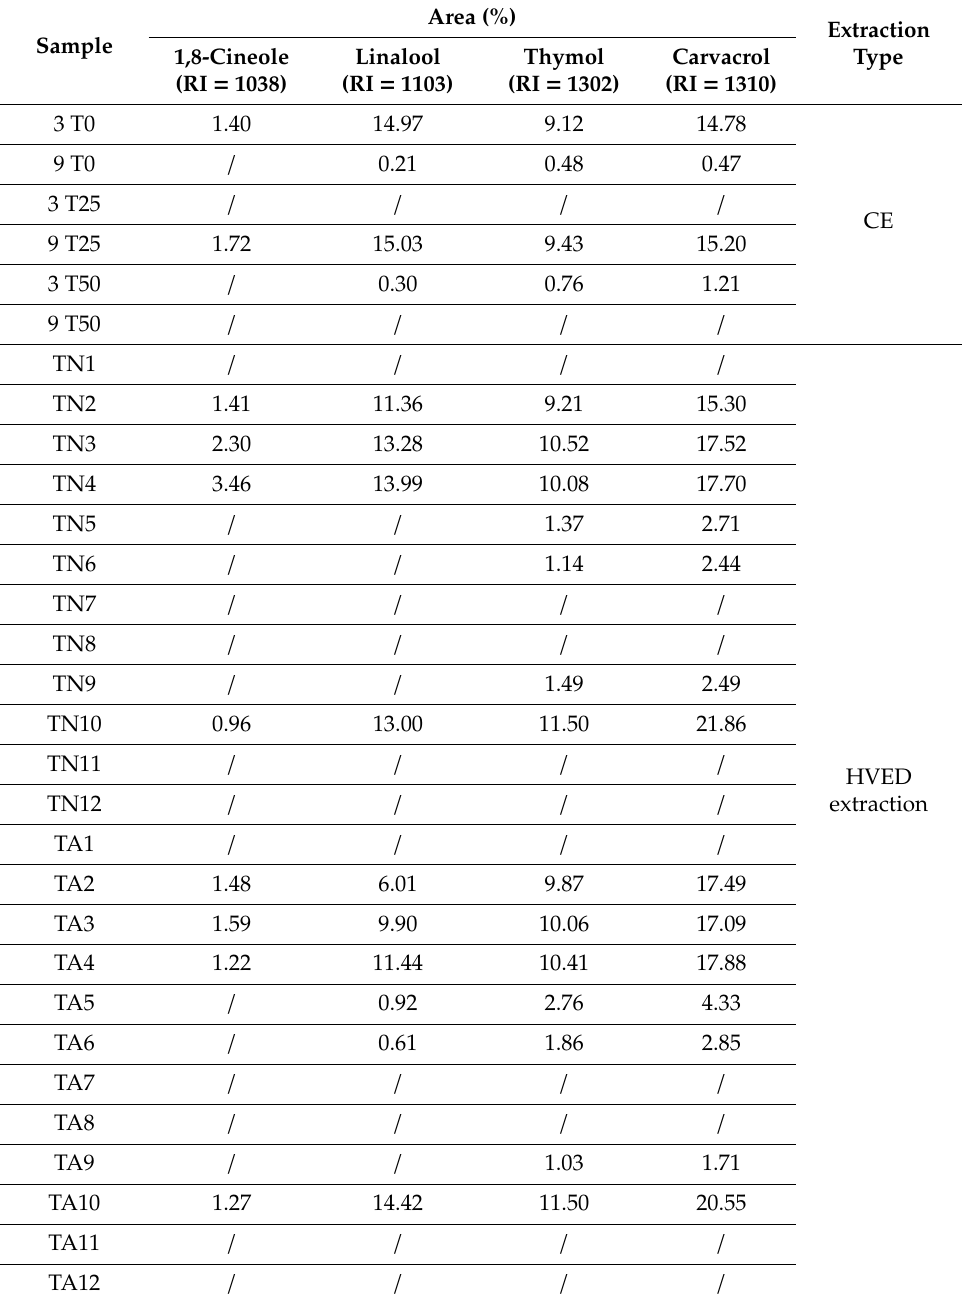
Table 5. GC-MS analysis of volatile compounds from wild thyme (measurements for CE and HVED treated samples)